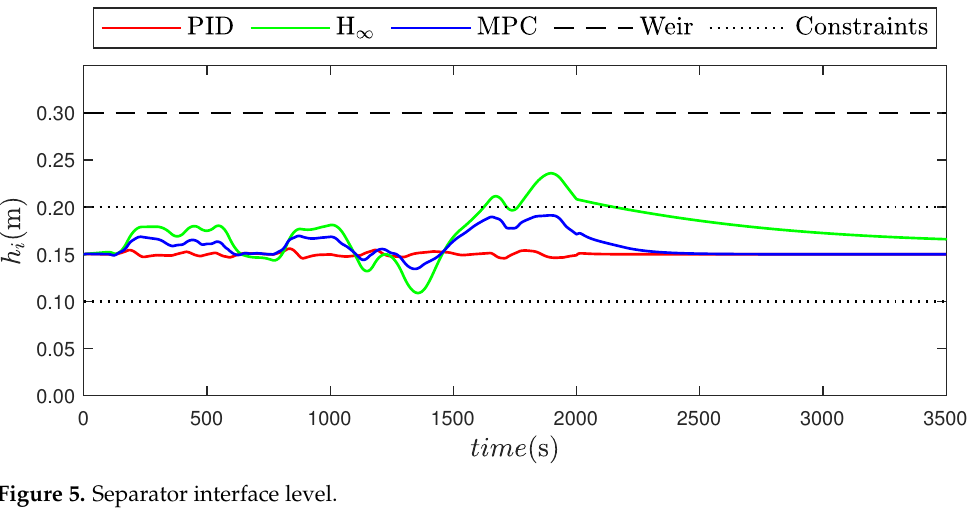
Figure 5. Separator interface level.